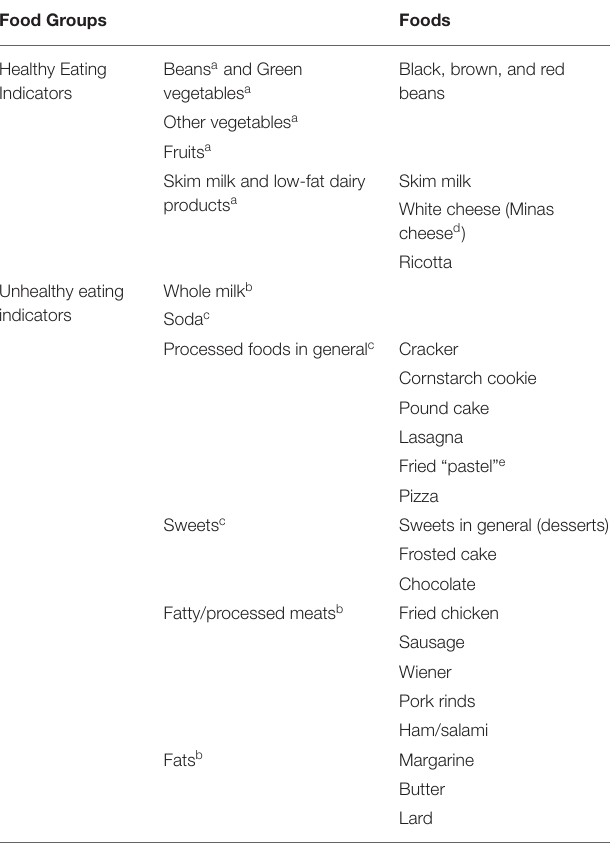
TABLE 1 | Classification of foods in groups of healthy and unhealthy eating indicators. Food